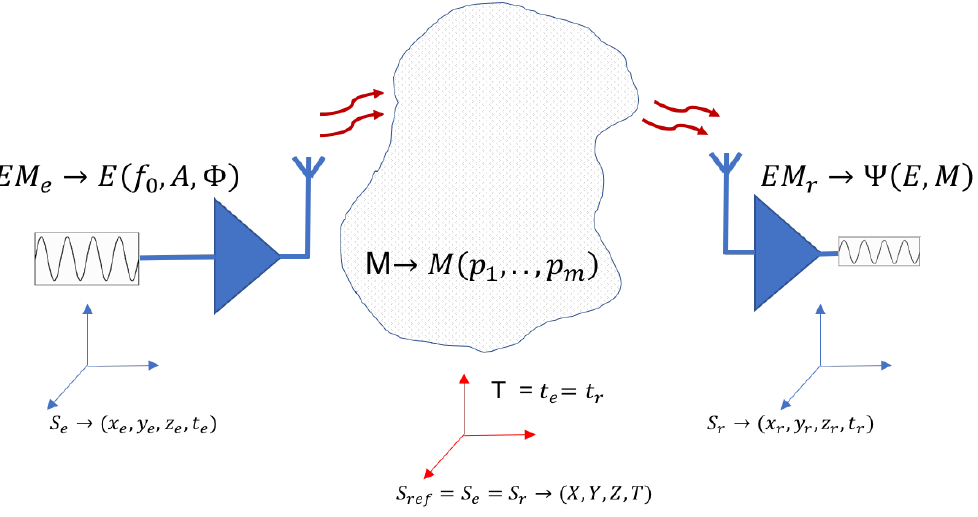
Figure 1. EM waves treatment in remote sensing applications. Devices need to synchronize the reference systems. Reference systems have the same reference